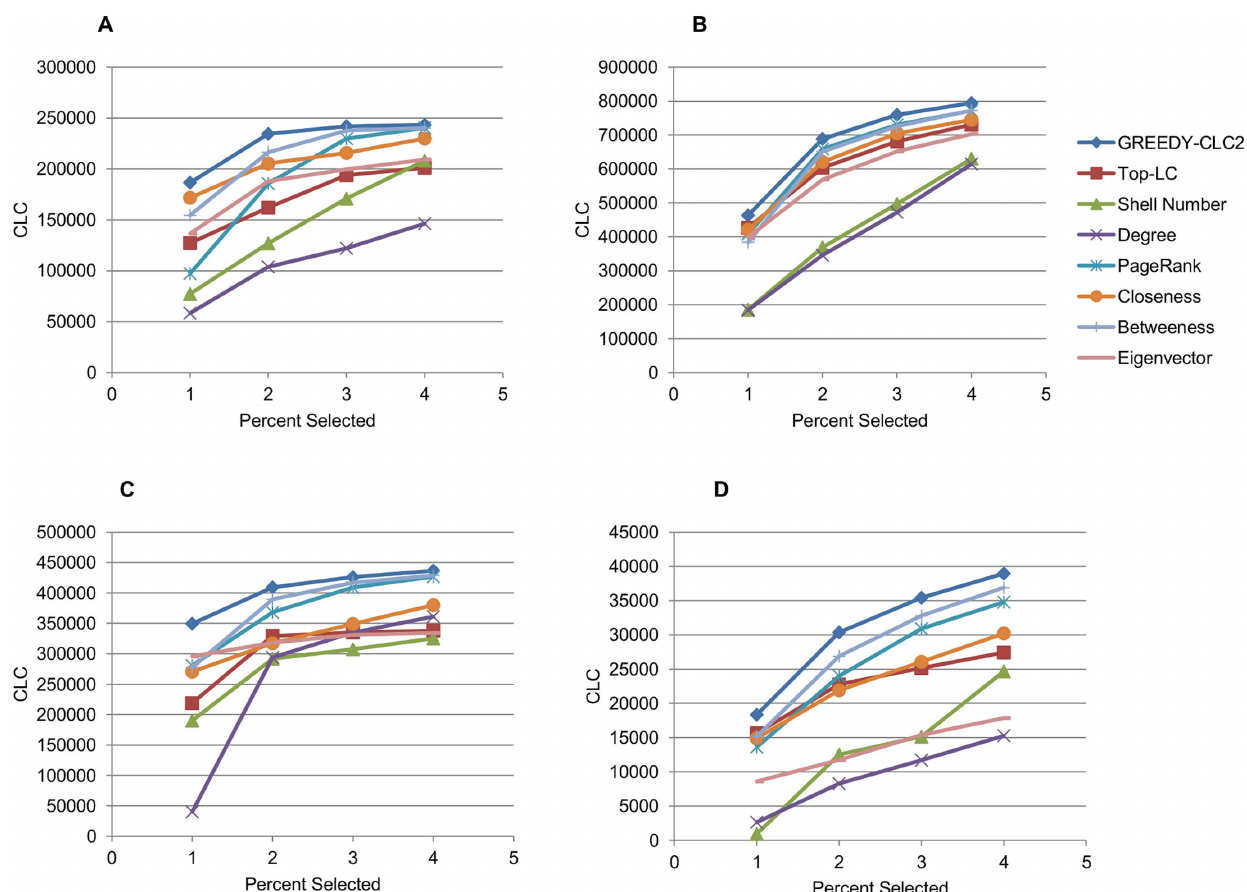
Figure 2. C LC of Sets Chosen with Various Centrality Measures. The C LC of sets chosen by various centrality measures. Sexual interaction, email, collaboration, and protein interaction networks are respectively graphs A, B, C, and D.